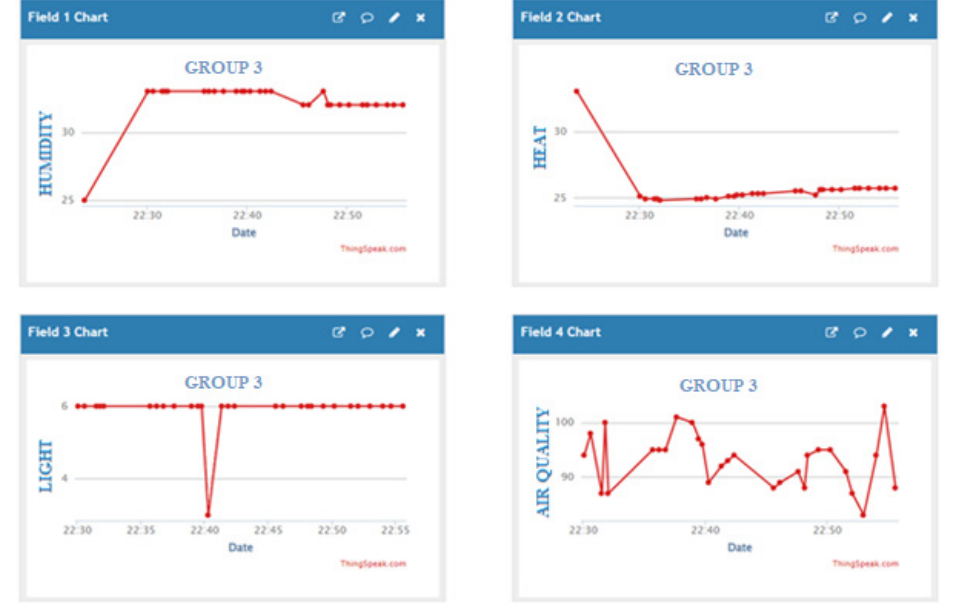
Figure 12. Data Figure 12. Data visualization .